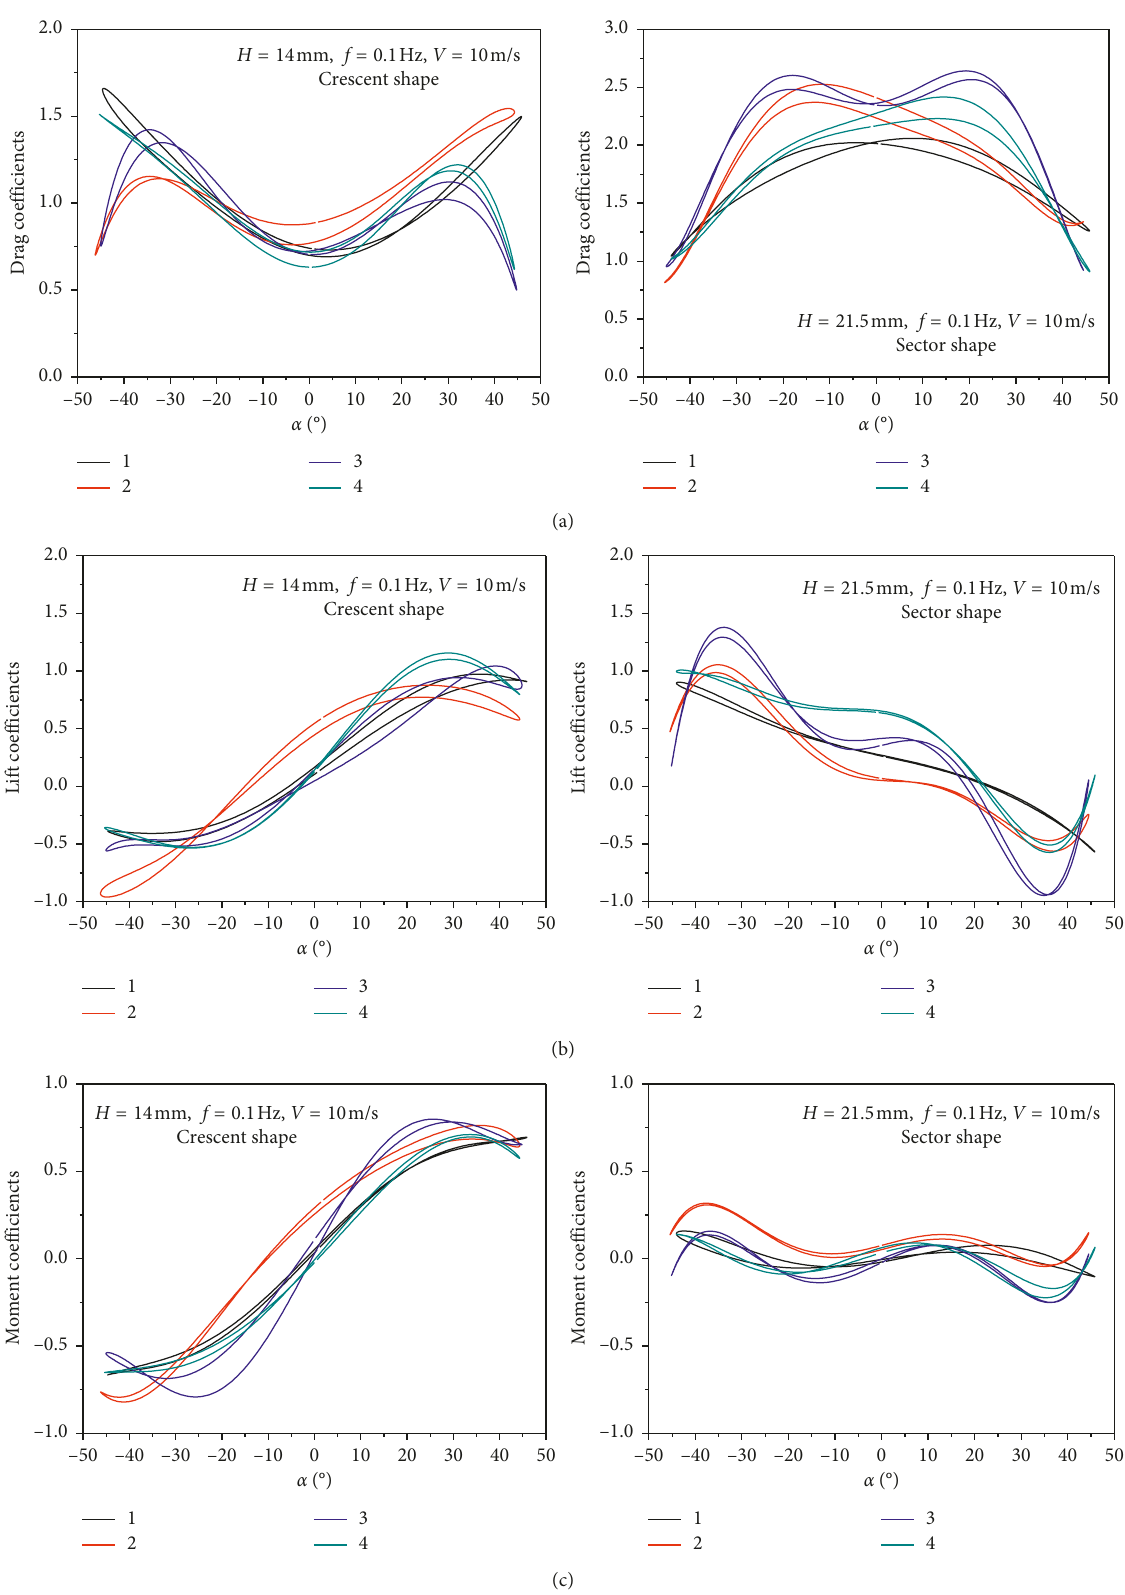
Figure 7: The unsteady aerodynamic coefficients of each iced subconductors: (a) drag coefficients; (b) lift coefficients; (c) moment